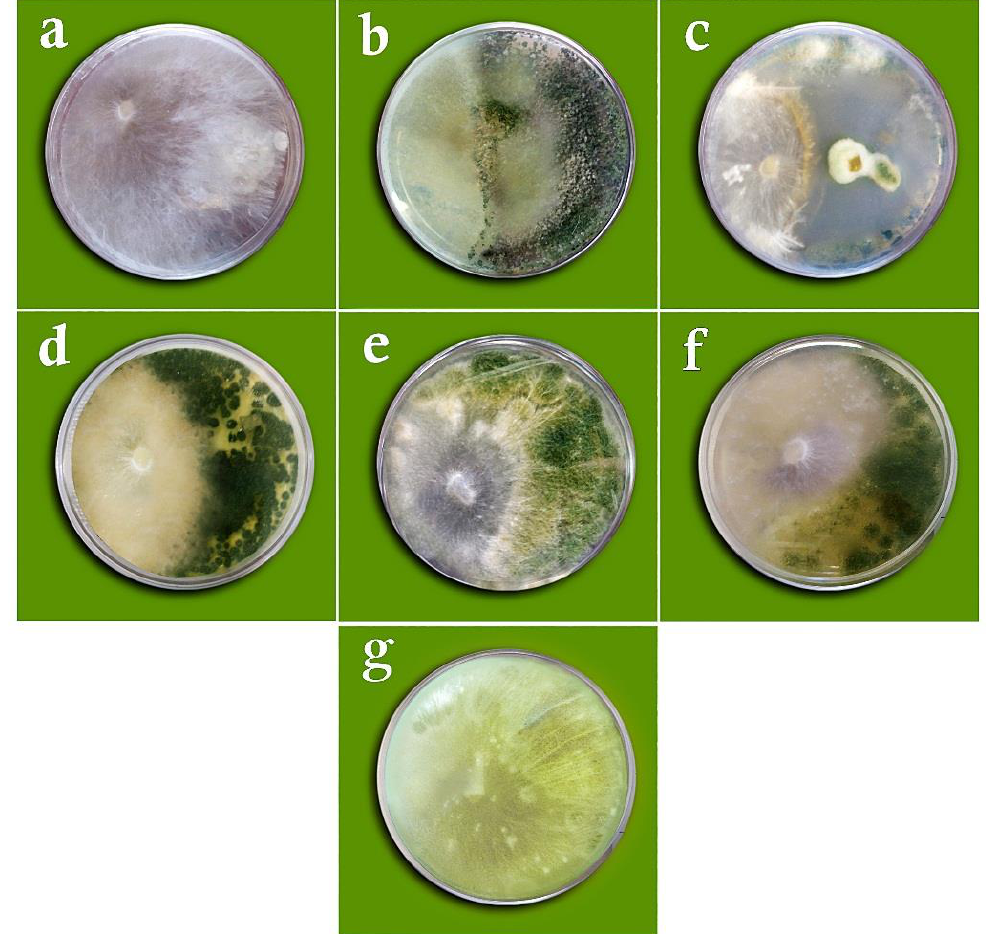
Figure 4. Dual culture test of Sclerotium rolfsii versus the studied fungi on the PDA medium: ( a ) Sclerotium rolfsii only (control), ( b ) Trichoderma viride , ( c ) Trichoderma virens , ( d ) Penicillium rubens (MN395854.1), ( e ) Aspergillus flavus , ( f ) Penicillium decaturense , ( g ) Penicillium rubens (MN395851.1).